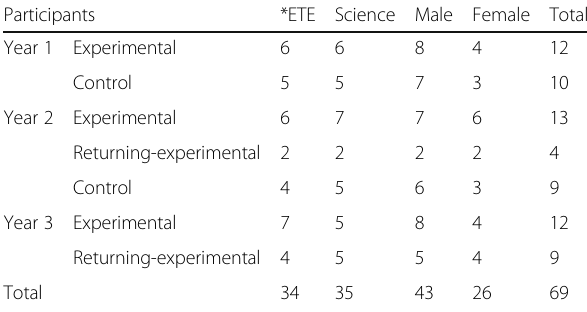
Table 2 Cohort 1 – 3 participant teacher